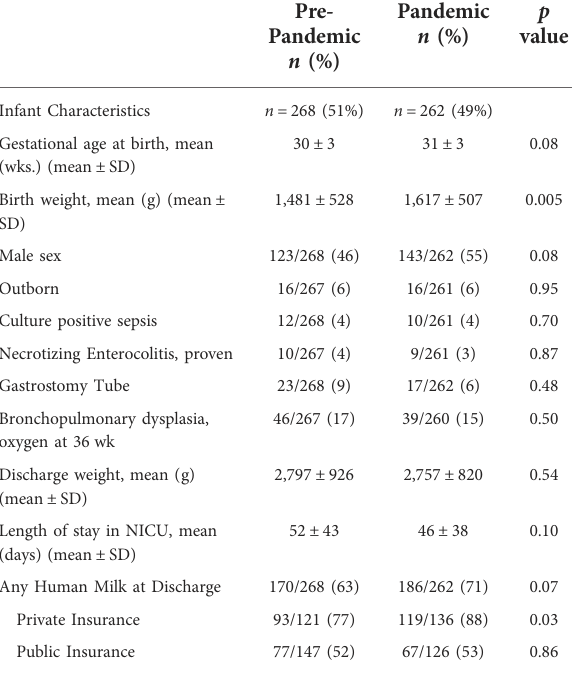
TABLE 2 Infant characteristics and medical complications.